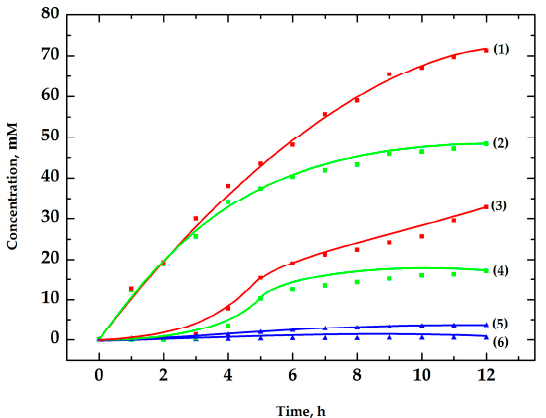
Figure 1. Dependence of product concentrations for ketone ( 1 ), alcohol ( 2 ), and epoxide ( 5 ) at 55 ◦ C and ketone ( 3 ), alcohol ( 4 ), and epoxide ( 6 ) at room temperature on time for the oxidation of 1 M cyclohexene with air catalyzed by 1 mM iron-salen species in acetonitrile.